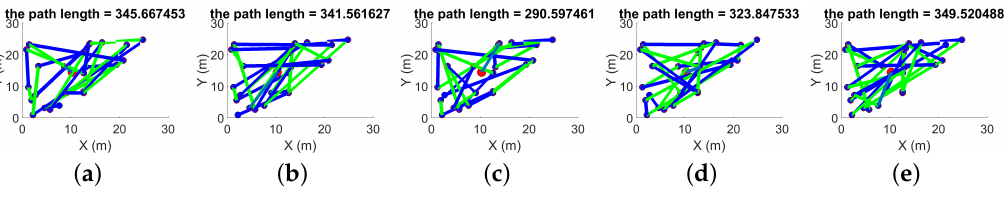
Figure 4. The constructed paths in iterations 16–20.